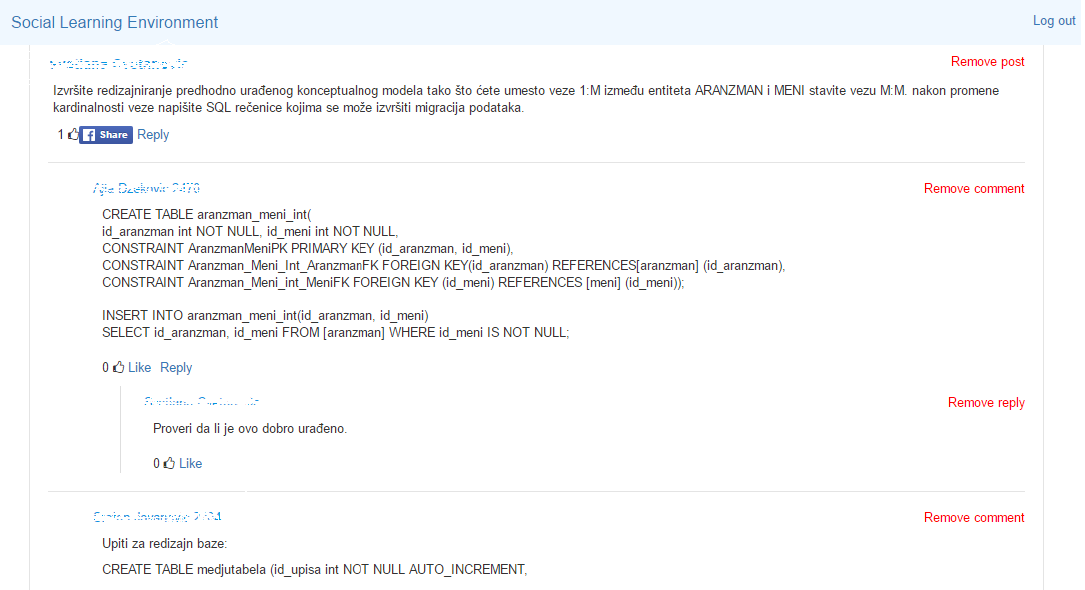
Figure 4. Example of a solved and discussed problem by a group of students in an online classroom model.